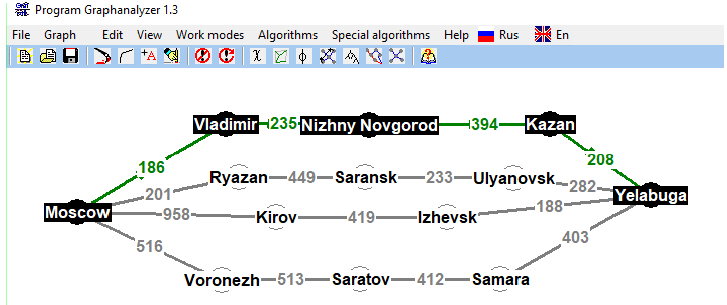
Fig. 1. Finding the shortest Moscow-Yelabuga